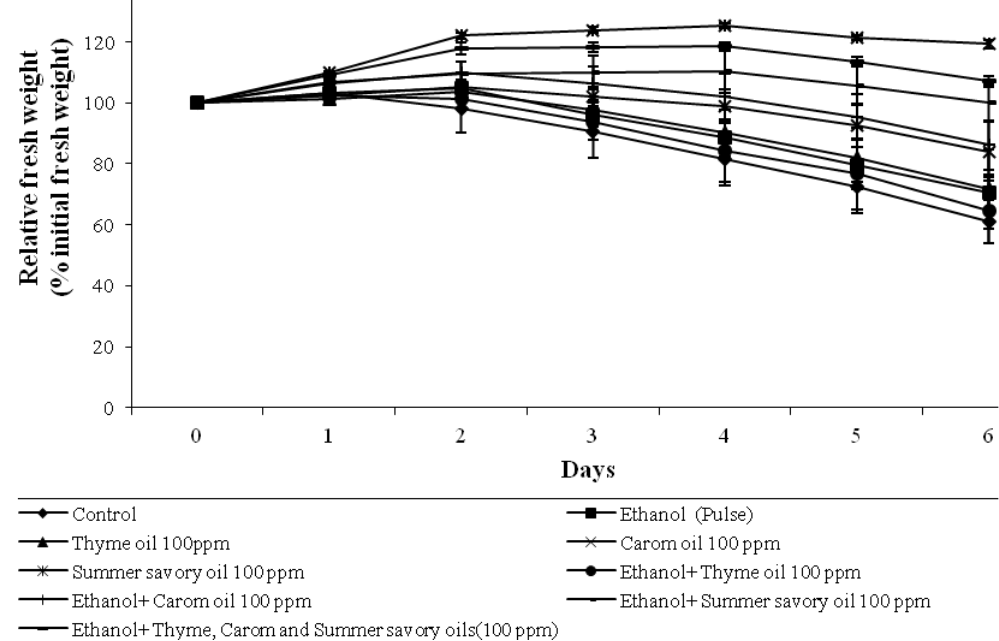
Fig. 6. Effect of pulse Et and 100 ppm concentration of different essential oils alone and in combination treatment on relative fresh weight during the first 6 day of the experiment (cv. ‘Yellow